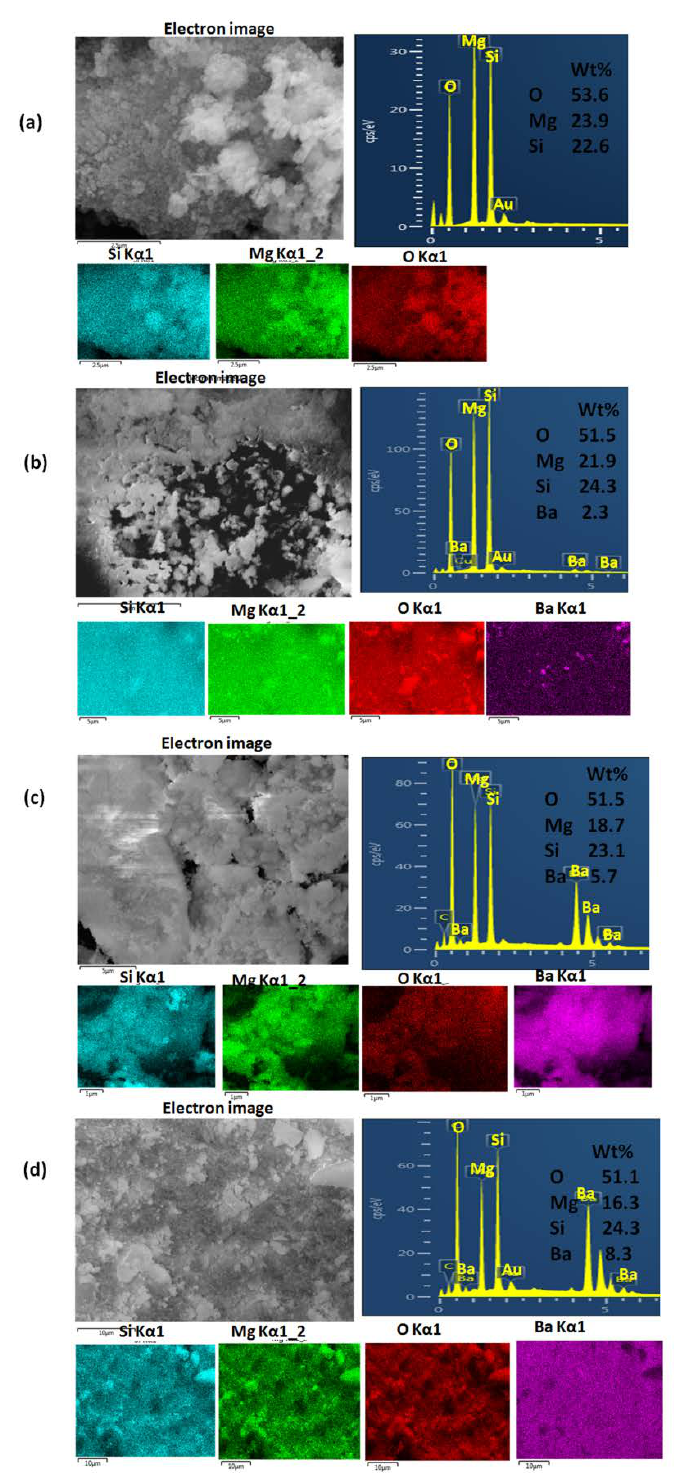
Figure 5. The electronic images, EDAX analysis chart and elemental mapping of ( a ) pure MgS, ( b ) MgS doped with 3% w/w BaO, ( c ) MgS doped with 5% w/w BaO and ( d ) MgS doped with 7% w/w BaO.